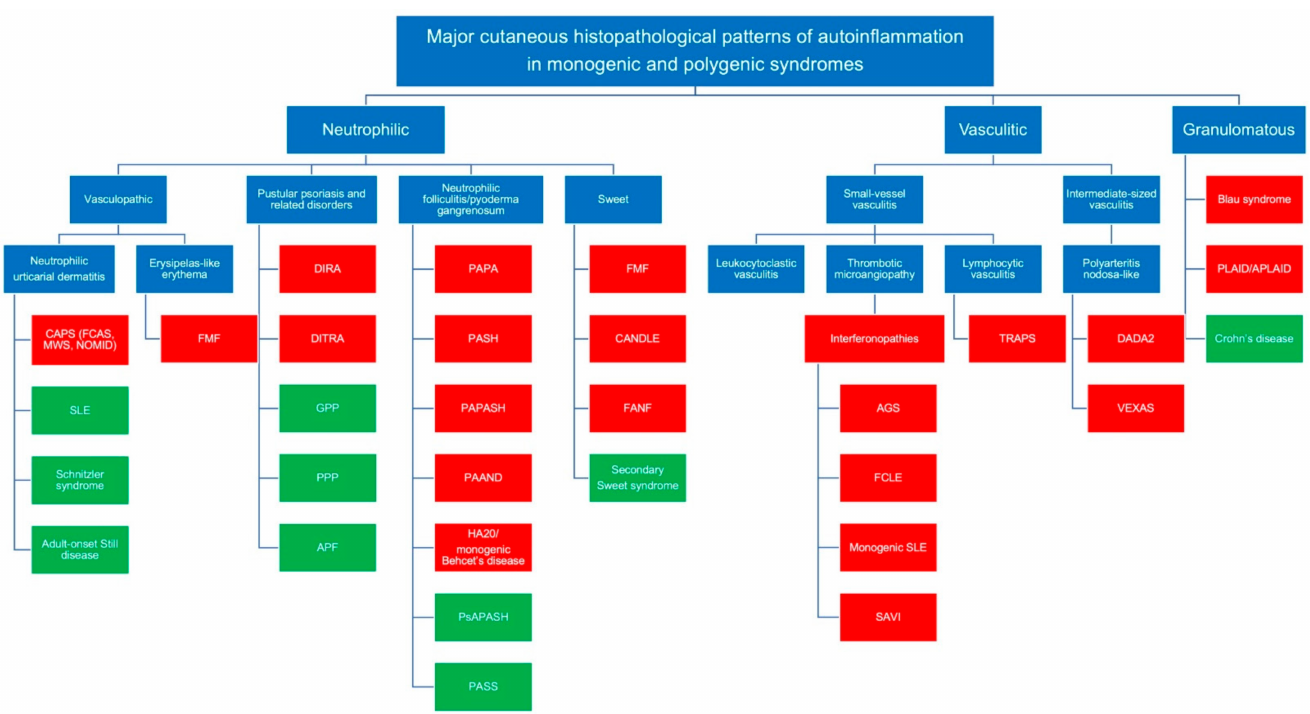
Figure 2. Major cutaneous histopathological patterns (neutrophilic, vasculitic and granulomatous) seen in autoinflammation in both monogenic autoinflammatory syndromes (Red) and complex multigenic diseases (Green); AGS, Aicardi Gouti è res syndrome; APF, Amicrobial pustulosis of the folds; APLAID, Autoinflammation and phospholipase C gamma 2 associated antibody deficiency and immune dysregulation; CANDLE, Chronic atypical neutrophilic dermatosis with lipodystrophy and elevated temperature; CAPS, Cryopyrin-associated periodic syndromes; DADA2, Deficiency of adenosine deaminase 2; DIRA, Deficiency of IL-1 receptor antagonist syndrome; DITRA, Deficiency of IL-36 receptor antagonist; FCAS, Familial cold autoinflammatory syndrome; FCLE, Familial chilblain lupus erythematosus; FANF, Familial autoinflammatory necrotising fasciitis; FMF, Familial Mediterranean fever syndrome; GPP, Generalized pustular psoriasis; HA20, Haploinsufficiency of A20; MWS, Muckle–Wells syndrome; NOMID, Neonatal-onset multisystem inflammatory disease; PAAND, Pyrin- associated autoinflammation with neutrophilic dermatosis; PAPA, Pyogenic arthritis, pyoderma gangrenosum and acne; PAPASH, Pyogenic Arthritis, pyoderma gangrenosum, acne, suppurative hidradenitis; PASH, Pyoderma gangrenosum, acne, suppurative Hidradenitis; PASS, Pyoderma gangrenosum, acne, suppurative hidradenitis and ankylosing spondylitis; PLAID, Phospholipase C gamma 2 associated antibody deficiency and immune dysregulation; PPP, Palmoplantar pustulosis; PsAPASH, Psoriatic arthritis, pyoderma gangrenosum, acne, suppurative hidradenitis; SAVI, Stimulator of interferon genes (STING) associated vasculopathy of infancy; SLE, Systemic lupus erythematosus; TRAPS, TNF receptor-associated periodic syndrome; VEXAS, vacuoles, E1 enzyme, X-linked, autoinflammatory, somatic